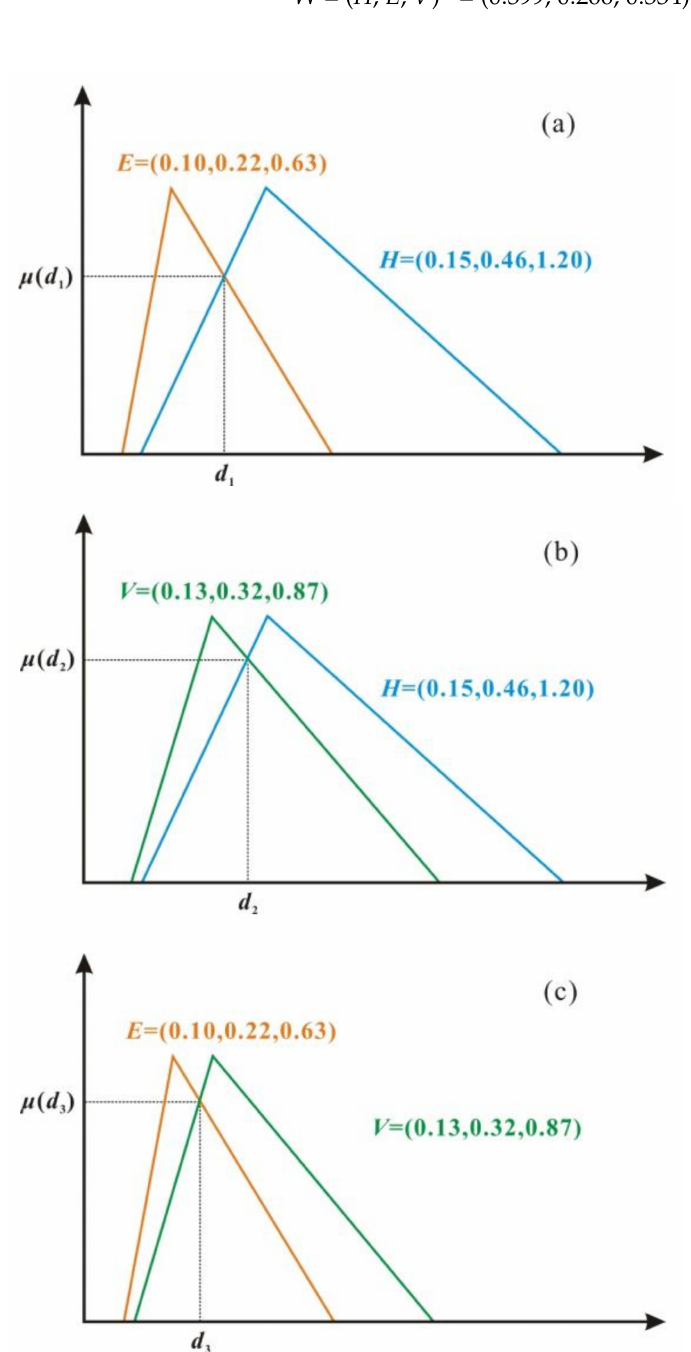
Figure 10. The possible degree of three risk assessment factors (hazard, exposure, and vulnerability) in the criterion layer. ( a ) µ ( P E ≥ P H ), ( b ) µ ( P V ≥ P H ), ( c ) µ ( P E ≥ P V ). Similarly, the fuzzy judgment matrix, fuzzy synthetic extent (Tables 2–4), and the weight of each risk assessment indicator (Table 5) of hazard ( H i ), exposure ( E j ), and vulnerability ( V k ) were calculated using the FAHP